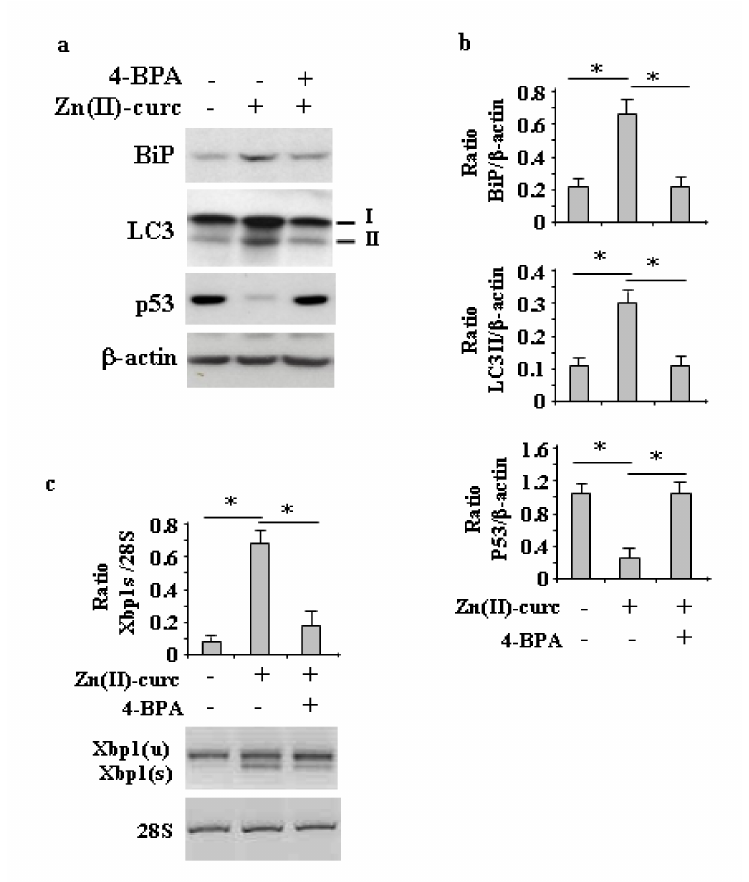
Figure 3. ER stress inhibition impairs Zn (II)-curc-induced autophagy and mutp53 degradation. ( a ) Western blot analysis of BiP, LC3I / II, and p53 protein levels in U373 cells untreated or treated with Zn(II)-curc (100 µ g / mL) for 24 h, with or without 1 h pre-treatment with 4-BPA (2.5 mM). ( b ) Densitometric analysis was performed using Image J software to calculate the ratio of the protein levels, as detected in ( a ), vs. β -actin. Histograms represent the mean ± SD of three independent experiments. * p ≤ 0.05. ( c ) Total mRNA was extracted from U373 cells untreated or treated as in ( a